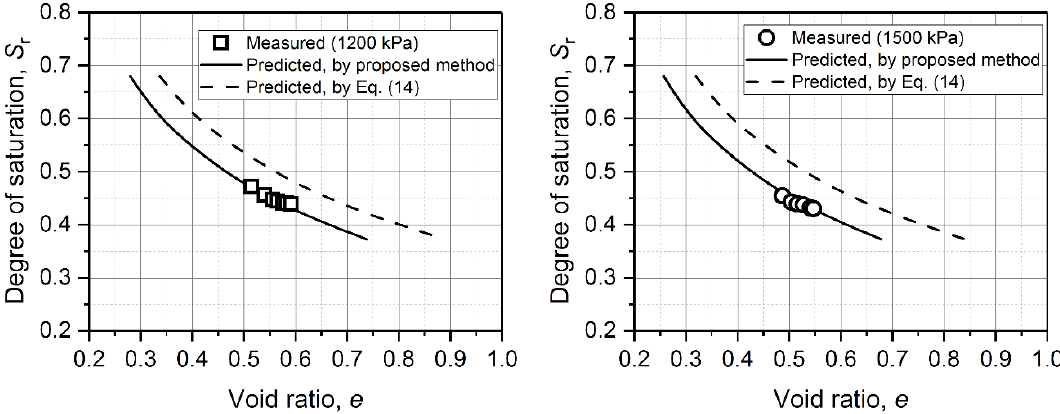
Figure 13. Measured and predicted HMCCs for sand bentonite at ( a ) s = 1200 kPa; ( b ) s = 1500 kPa.